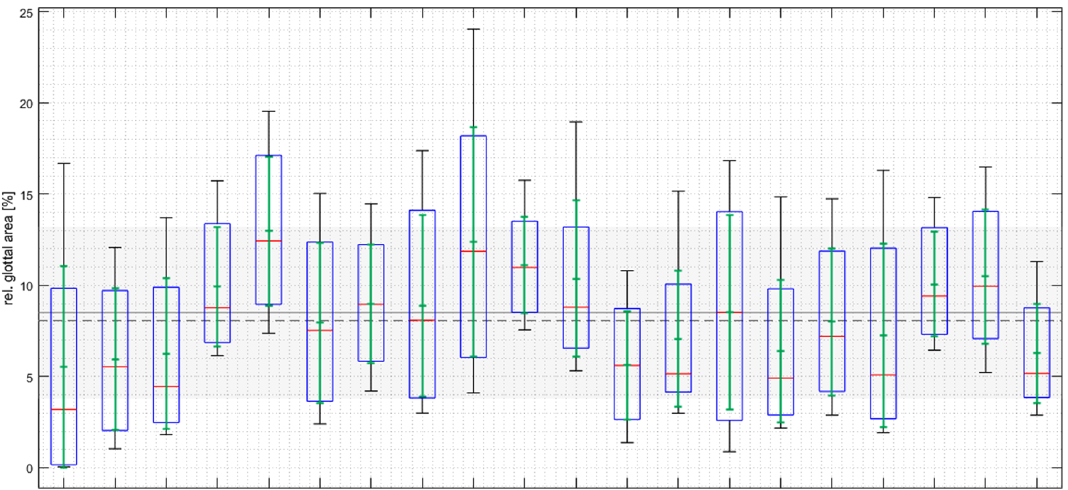
Figure 3. The relative glottal area for sequences with insufficient closure (20 cases): 8.5% ± 4.71% (8.07%). Variations of insufficient closure of the vocal folds during phonation. Twenty subjects/videos with a rear glottal gap included in this paper were chosen from our database and analyzed with deep learning. The highest relative glottal area was 24.04%, and the lowest relative glottal area was 0.05%. The mean highest relative glottal area was 15.7%, and the mean lowest glottal area was 3.5%. None of the 20 subjects with a rear glottal gap had full glottal closure, as shown by the relative glottal area not reaching zero. The relative area is calculated as the glottal area divided by the left and right vocal folds plus the glottal area.